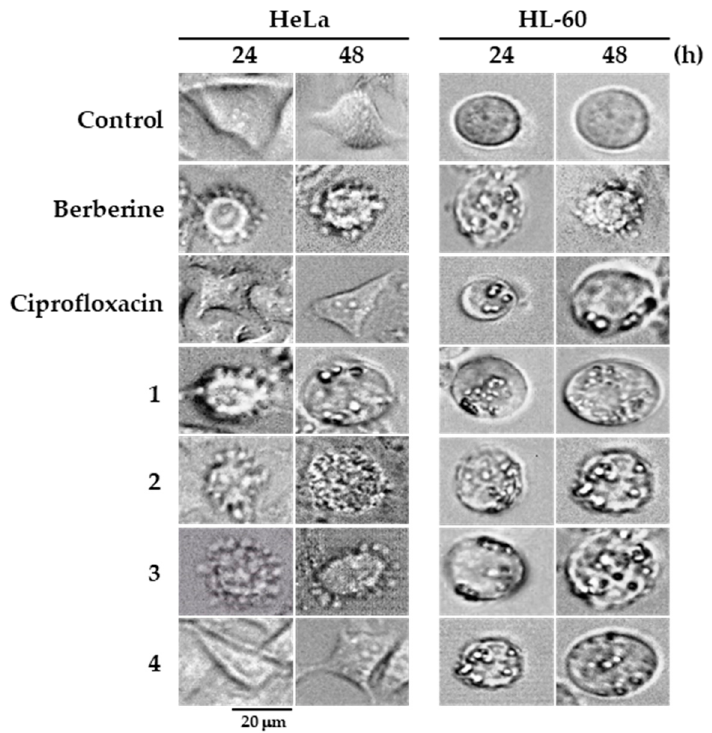
Figure 5. Assessment of changes in cellular morphology of HeLa and HL-60 cells treated with berberine, ciprofloxacin, and berberine derivatives (10 µM) for the time indicated. Magnification of microscope: ×600.